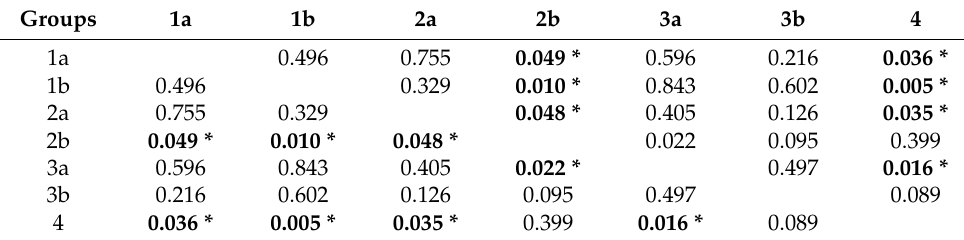
Table 3. The mean micro-leakage score for the total-etch (ER) and self-etch (SE) adhesive systems.